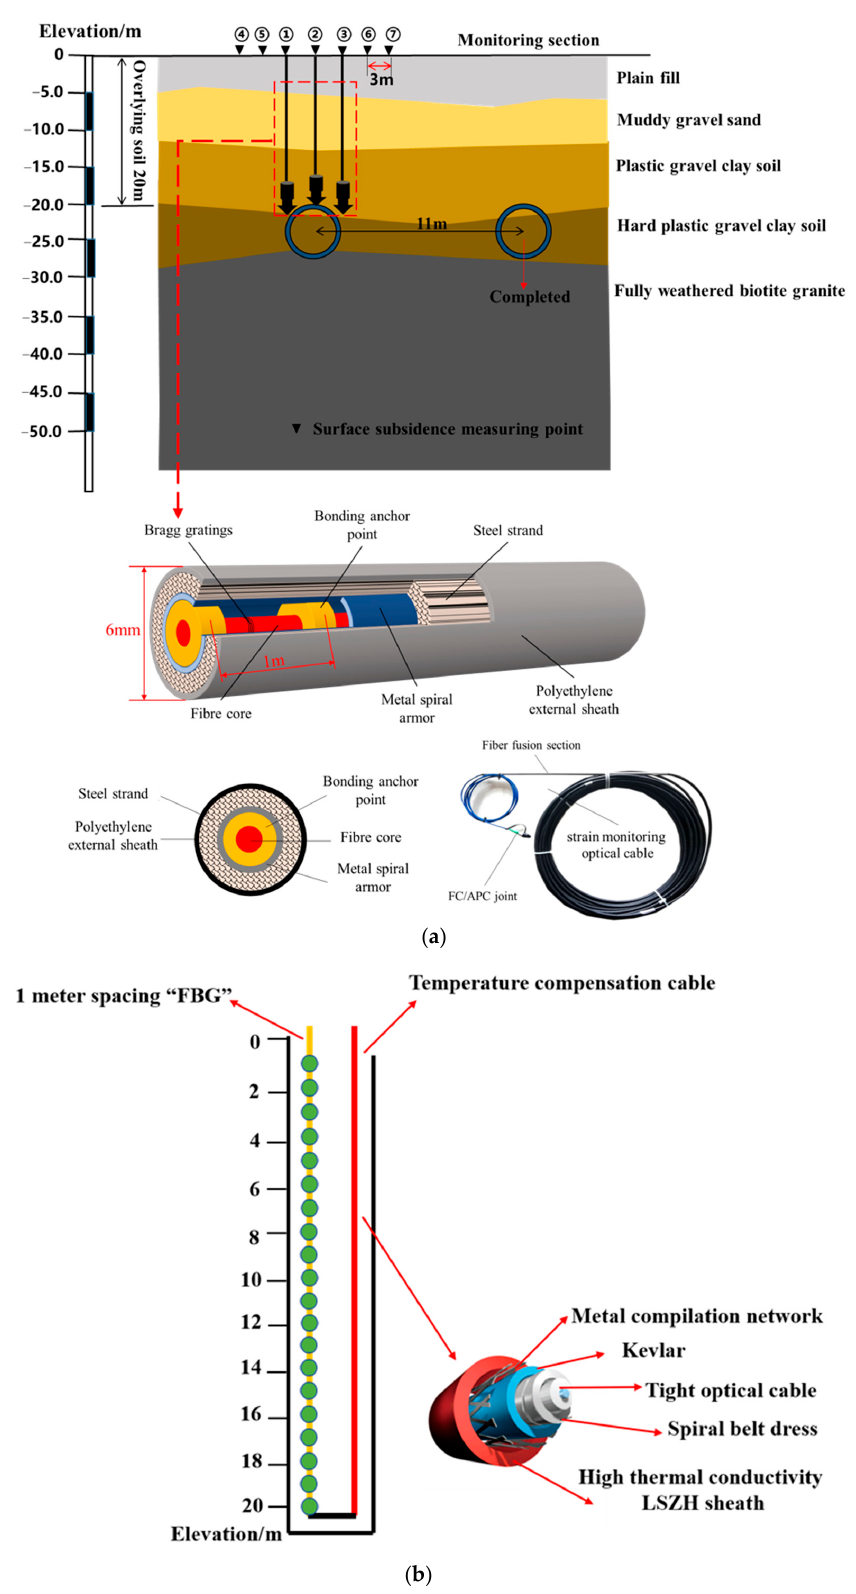
Figure 2. Layout of monitoring system. ( a ) Monitoring section layout. ( b ) Optical cable layout. The wavelength range of the demodulator used in the field test is 1528~1568 m, the wavelength resolution is 1 pm, and the repeatability is ±2 pm. Internal 4-channel design, single-channel demodulation rate < 5 s, single-channel measurement distance up to 20 km, the maximum number of measuring points 2000, all meet the test requirements. The initial monitoring began at 21:37 on 15 November 2021. The longitudinal hori- zontal distance between the shield cutter head and the monitoring section was 30 m, and the shield was progressing at a rate of 4 rings/day (about 1.5 m per ring). The shield cutter head reached the bottom of the monitoring section at 21:30 on 20 November. At 21:25 on 21 November, the shield body was detached entirely (the longitudinal horizontal distance between the cutter head and the monitoring point was 6 m) and moved forward till it was connected. 2.3. Establishment of Numerical Simulation Model Based on site engineering survey and full consideration of tunnel excavation process stability, the calculation model was reasonably simplified, and the following basic as- sumptions were made in the finite element numerical simulation calculation: (1) it was assumed that the rock and soil mass (using the Mohr-Coulomb constitutive model) is ho- mogeneous and isotropic in the same stratum; (2) the groundwater is in a lower position, without considering the seepage effect and the soil deformation’s time effect, that is, with- out considering the secondary consolidation and creep effect of the stratum, and with as- suming that the shield advance is a change in spatial displacement; (3) it was assumed that the shield advancing process is continuous, and the advancing length of each shield ring is 1.5 m; (4) in the calculation process, some parameters were adjusted appropriately to make the calculation more reasonable. The three-dimensional numerical simulation modeling of the shield tunnel is carried out using ABAQUS nonlinear finite element analysis software. In this study, the stratum soil, shield, and lining segments were simulated using three-dimensional solid 8-node hexahedral linear reduced integration elements (C3D8R), making up a total number of 184,380 numerical model elements.